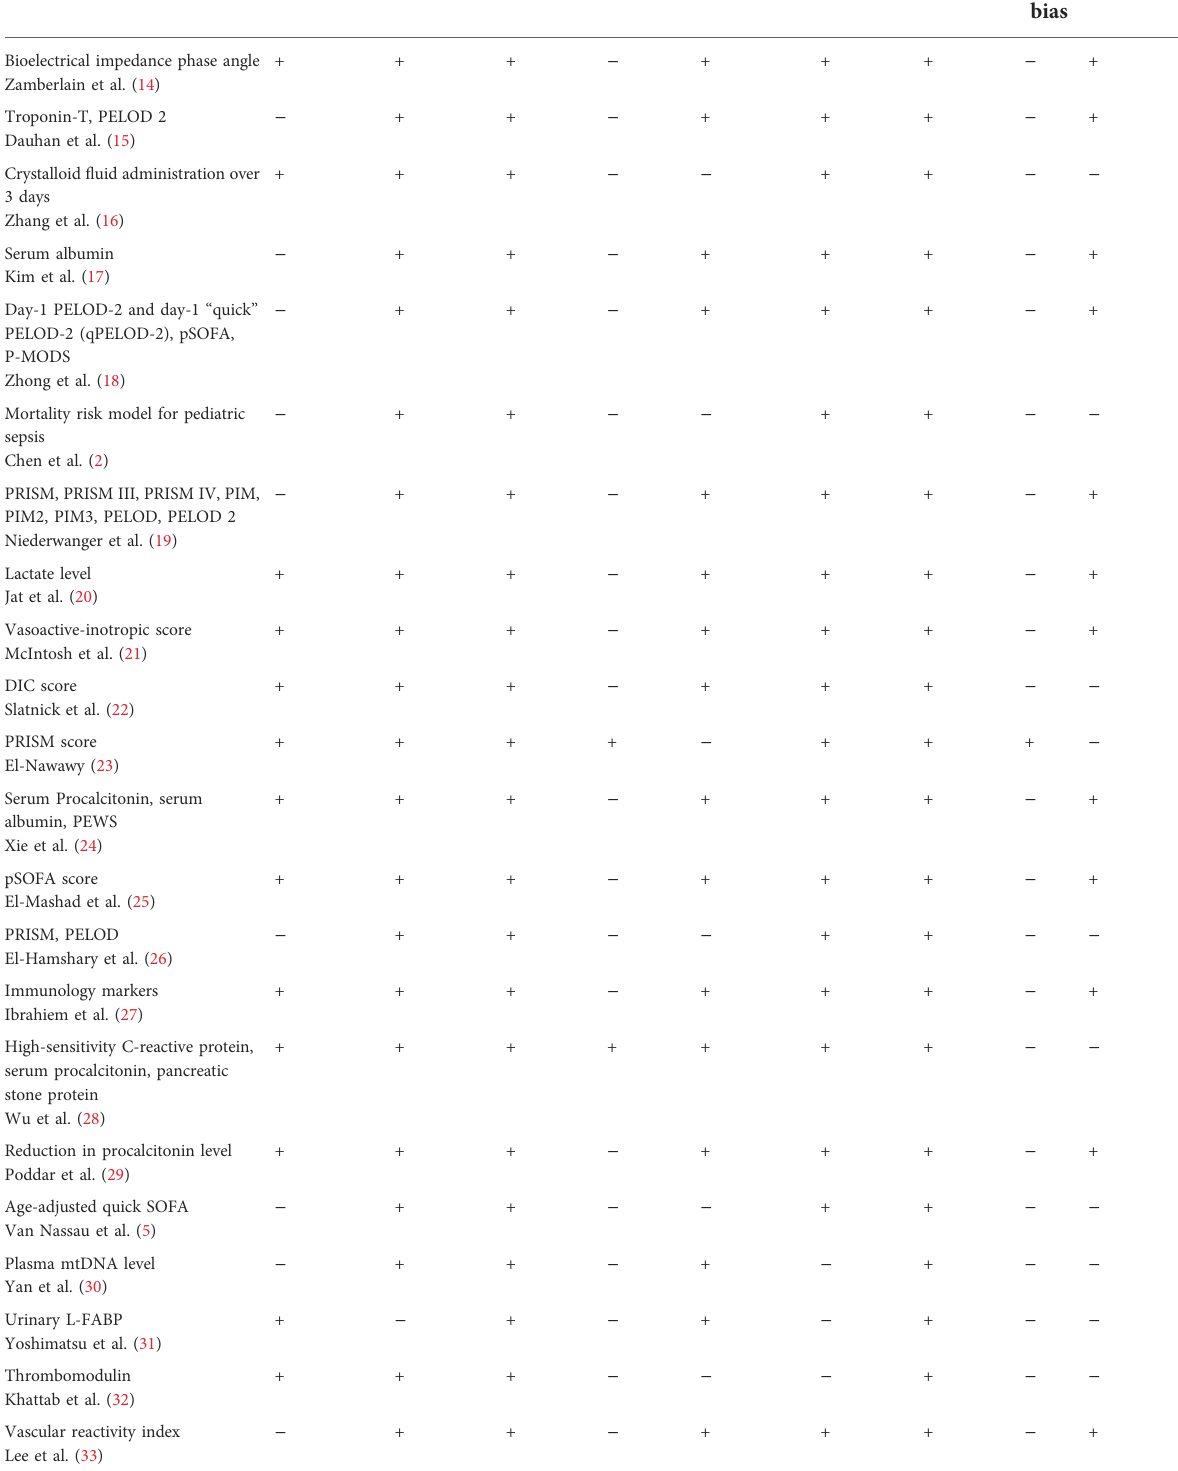
TABLE 3 Performance of mortality prediction